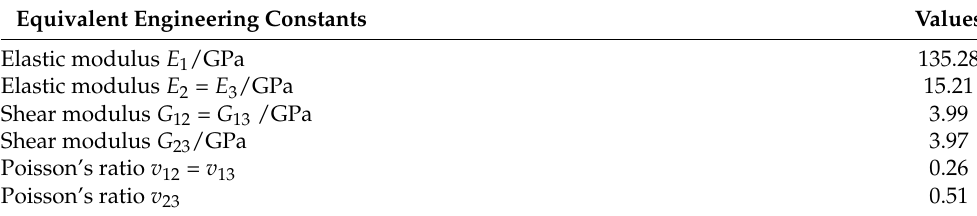
Table 2. Equivalent engineering constants of the yarn with a fiber volume fraction of 64%.